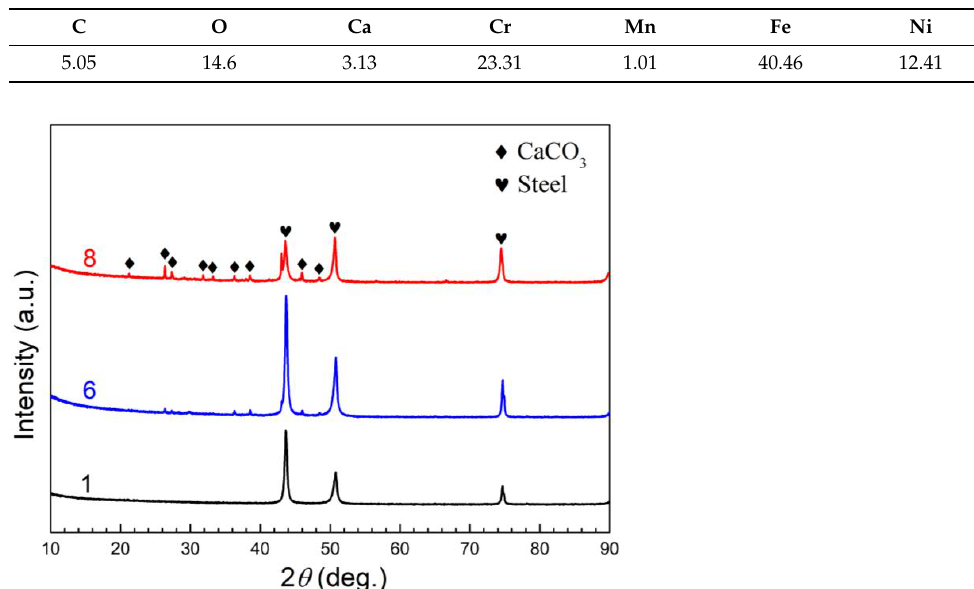
Figure 8. SEM-EDS mapping of elements for the area marked by the blue rectangle at point A in Figure 7f.